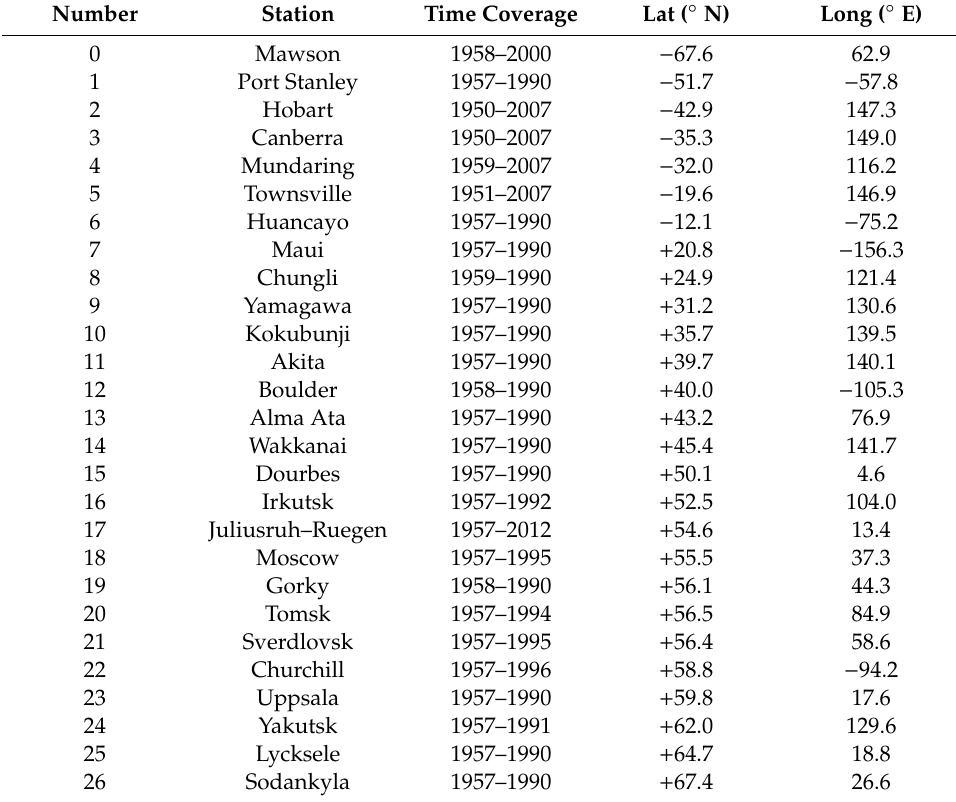
Table 1. List of ionosonde